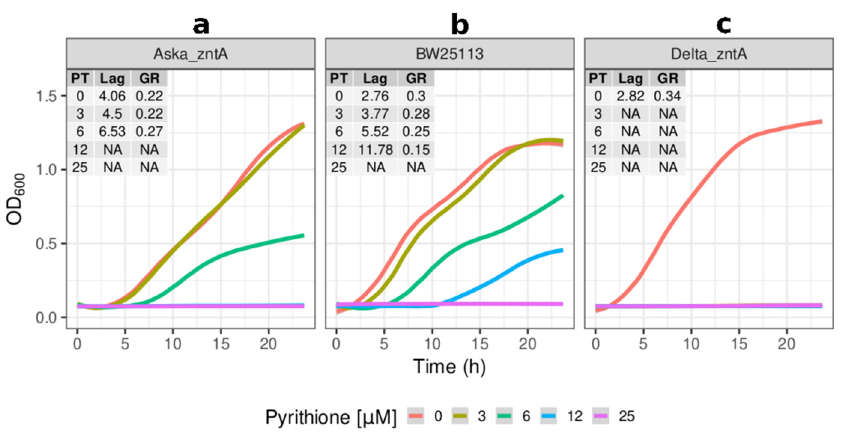
Figure 3. Effects of zntA in the sensitivity of E. coli to pyrithione. Growth (OD 600 ) at incremental concentrations of pyrithione in complex media (LB) of the ( a ) Aska clone carrying episomal copies of zntA (Aska_zntA), ( b ) the reference strain BW25113, and ( c ) the zntA knockout strain (Delta_zntA). Insets: PT: concentration of pyrithione in micromolar ( µ M), Lag: length of lag phase in hours, GR: growth rate fitted from optical densities of the cultures in exponential phases. The colour coded lines represent the fitted data with the parametric non-linear method of least squares. NA (non-applicable): data below detection